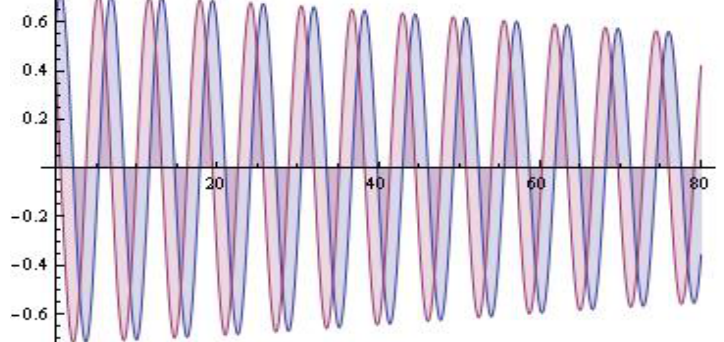
Figure 4. The system solutions ( (cid:101) = 0.006; n = 7).